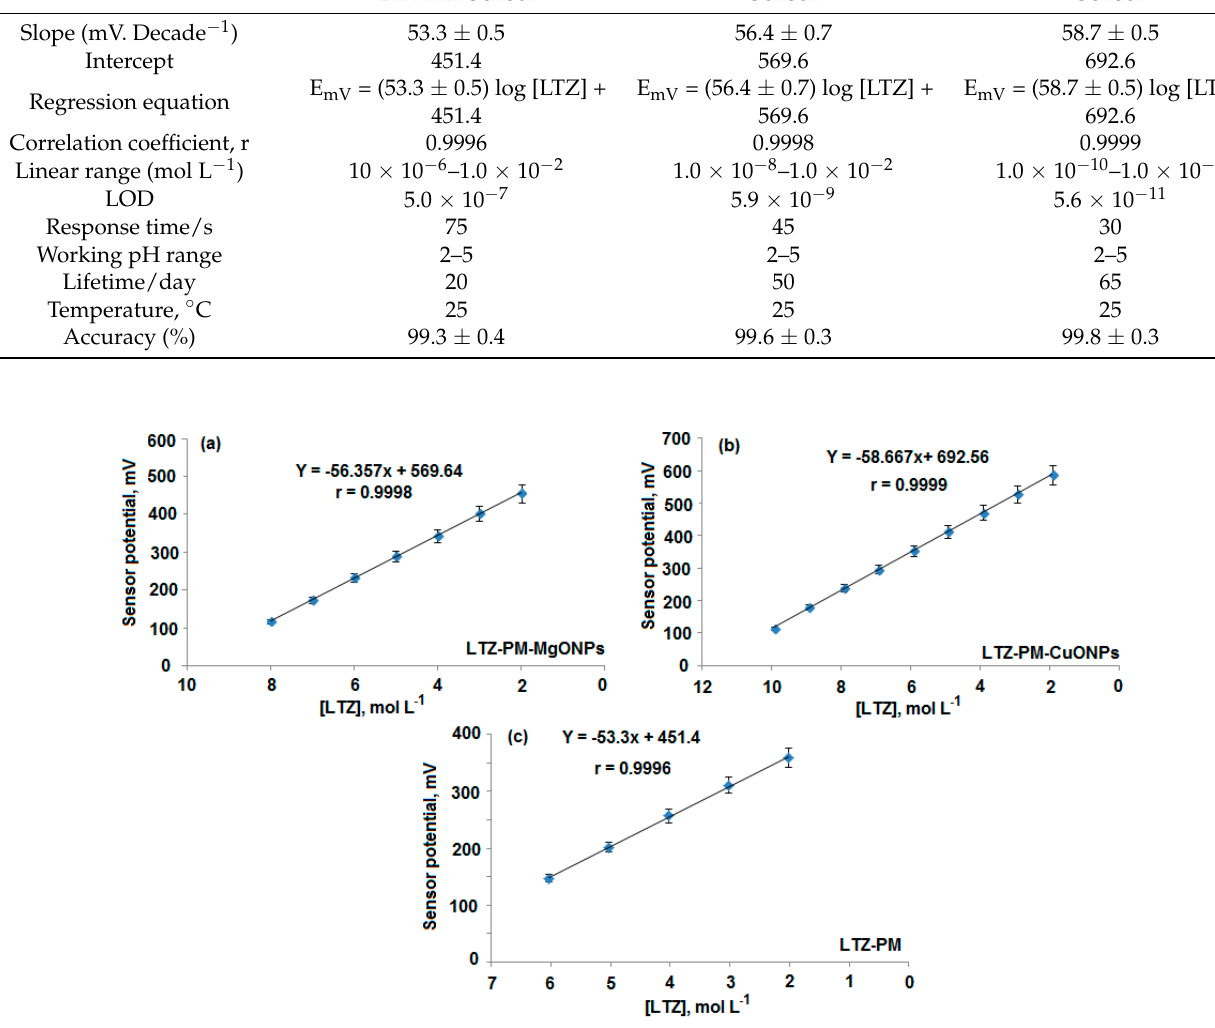
Figure 7. Calibration graphs for the determination of 1.0 × 10 − 8 –1.0 × 10 − 2 , 1.0 × 10 − 10 –1.0 × 10 − 2 and 1.0 × 10 − 6 –1.0 × 10 − 2 mol L − 1 LTZ using the fabricated ( a ) modified LTZ-PM-MgONPs, ( b ) LTZ-CuONPs and ( c ) conventional LTZ-PM coated wire sensors, respectively.